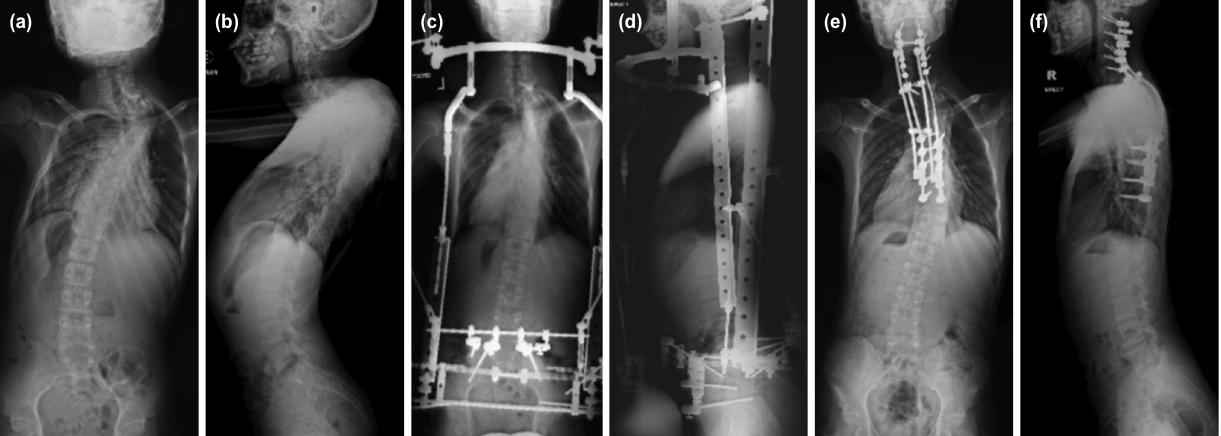
Plain radiographs (posteroanterior or and lateral view) of Case 1: (a, b) before operation, (c, d) while on halo-pelvic traction, and Fig. 1: (e, f) after single-stage posterior spinal fusion.